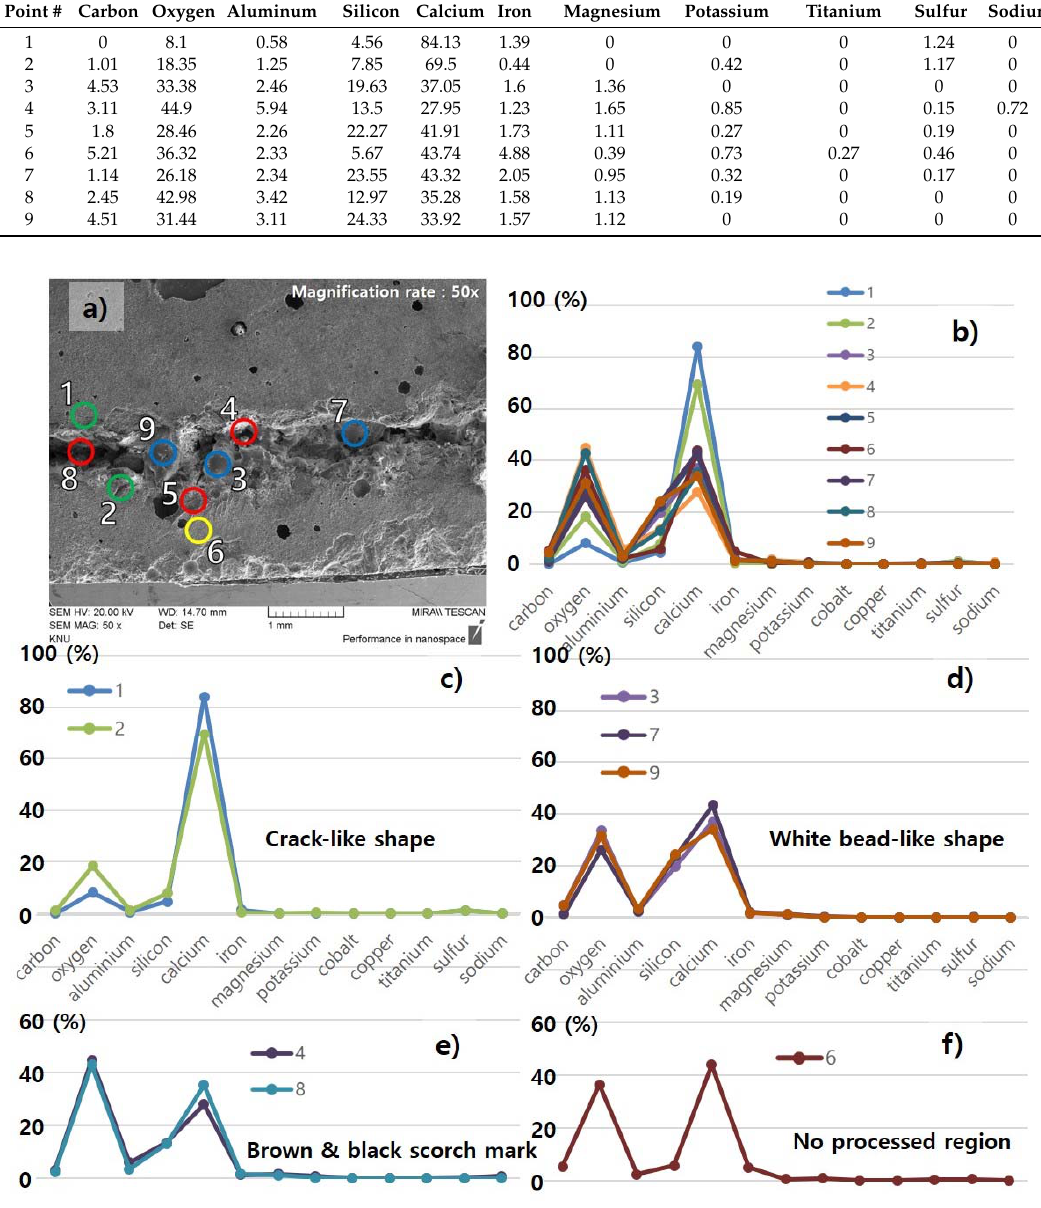
Figure 12. EDX analysis of LM0.4 with a cutting speed of 12 m/min, ( a ) measured points of white bead ‐ like shape (Blue), brown & black scorch marks (Red), and crack ‐ like shape (Green); ( b ) comparison of all measured points; ( c ) component distribution of the crack ‐ like shape; ( d ) component distribution of the white bead ‐ like shape; ( e ) component distribution of the brown and black scorch mark; ( f ) component distribution of non ‐ processed region.